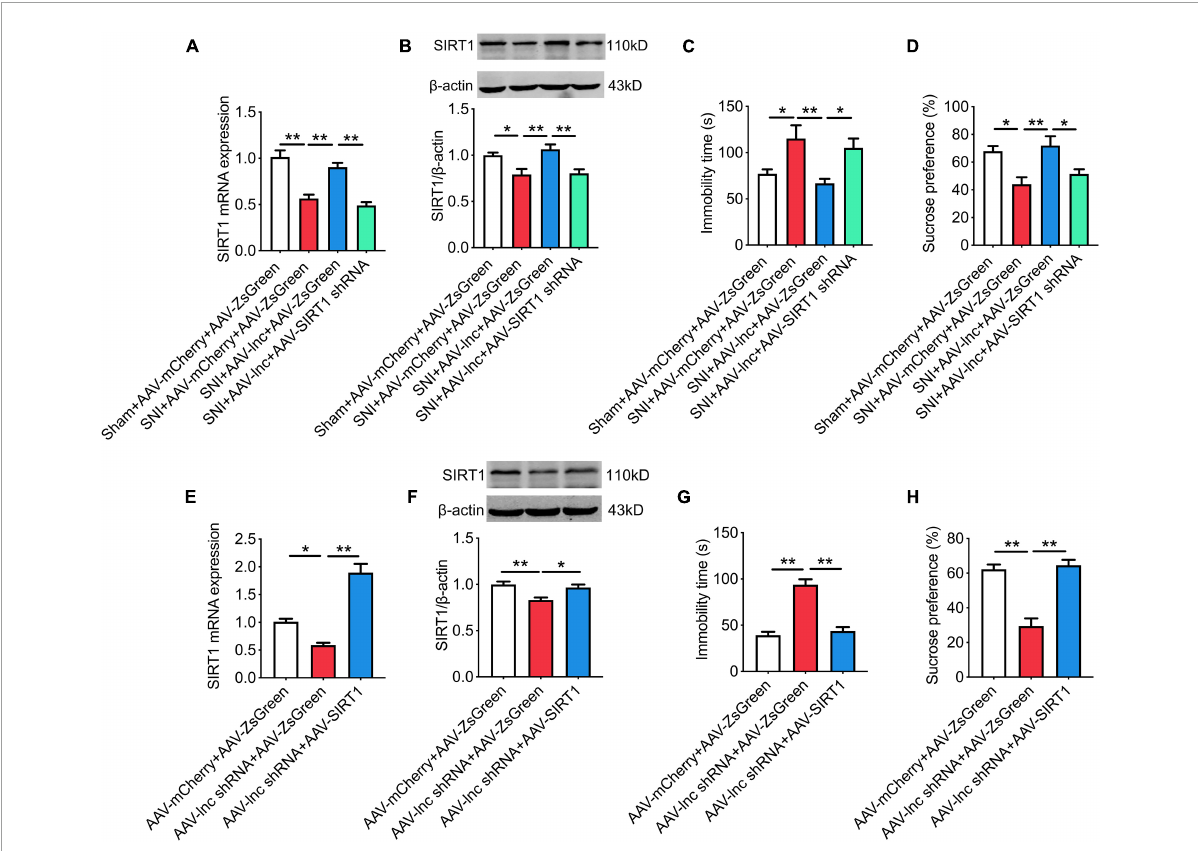
FIGURE8 SIRT1 is essential for lncRNA-84277 to regulate chronic pain-related depression. (A,B) Effect of SIRT1 knockdown on lncRNA-84277 overexpression-mediated increase of SIRT1 mRNA (A) and protein (B) levels in SNI rats. (C,D) Effect of SIRT1 knockdown on lncRNA-84277 overexpression-mediated improvement of depression-like behaviors in SNI rats determined by the forced swim test (C) and the sucrose preference test (D) . (E,F) Effect of SIRT1 overexpression on lncRNA-84277 knockdown-mediated decrease of SIRT1 mRNA (E) and protein (F) levels in naïve rats. (G,H) Effect of SIRT1 overexpression on lncRNA-84277 knockdown-mediated depression-like behaviors in naïve rats determined by the forced swim test (G) and the sucrose preference test (H) . All data are expressed as the mean ± SEM. n = 8 for each group. * P < 0.05, ** P < 0.01.